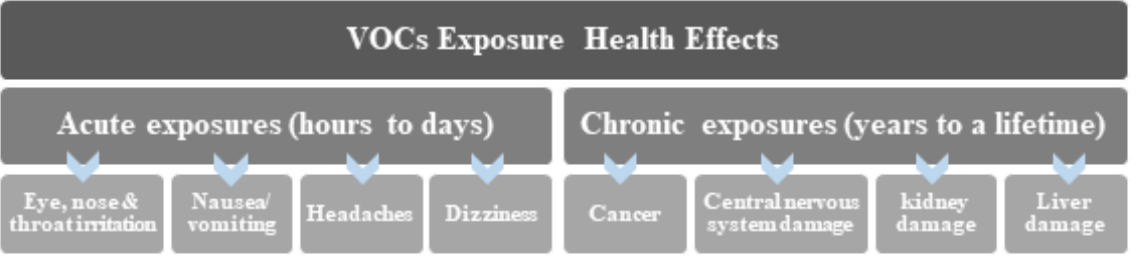
Figure 1. Common symptoms of exposure to high levels of VOCs (Bluyssen,